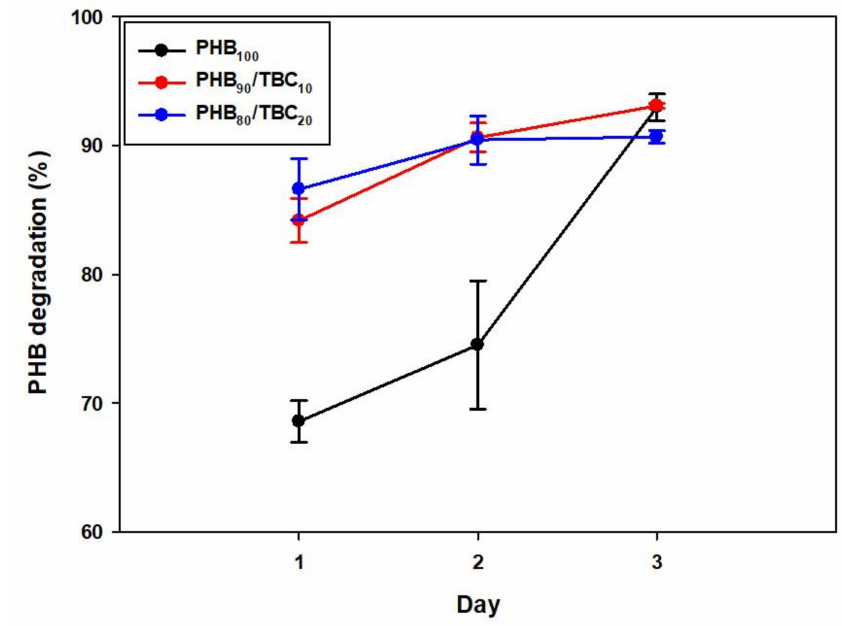
Figure 6. Time-dependent analysis of PHB biodegradation by Microbulbifer sp. SOL66. Comparison of the degradation rate of non-plasticized PHB film, and tributyl citrate plasticized PHB